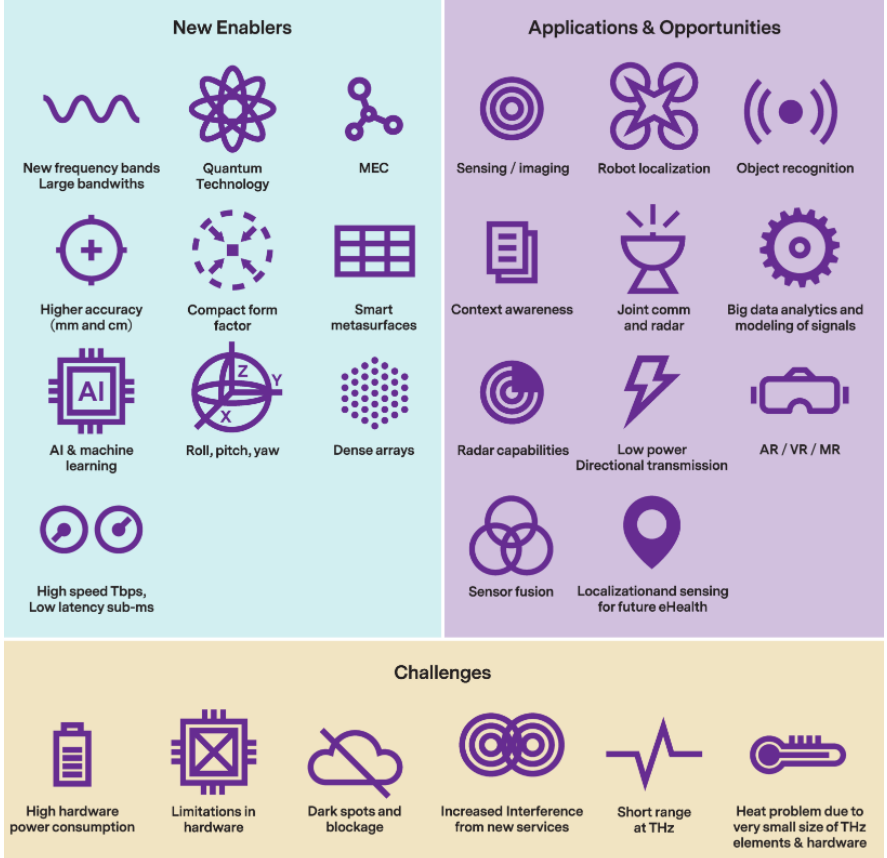
Figure 6. The enablers, new applications, and challenges of 6G